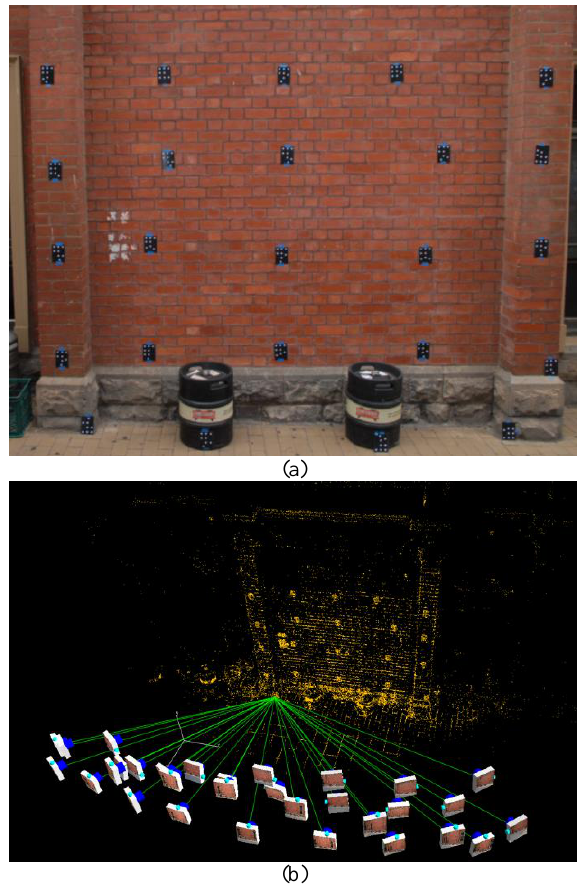
Figure 5. Configuration for 55,500-point ‘Sandstone’ self- calibration network.